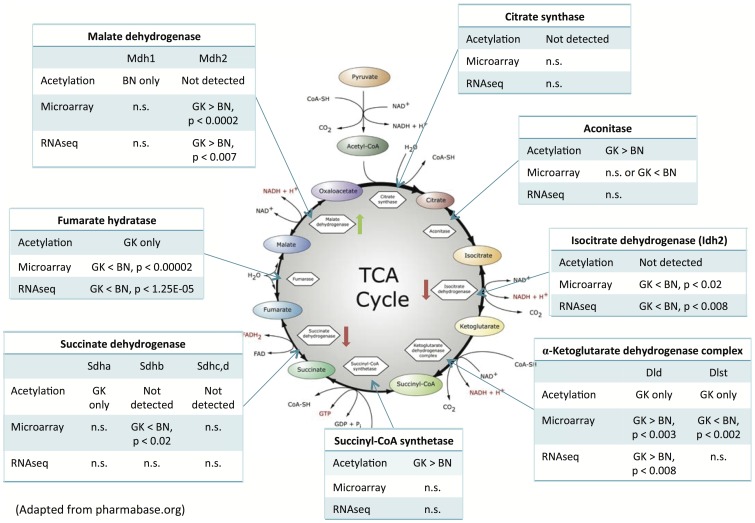
Lysine acetylation and mRNA expression in components of TCA cycle.Green arrow pointing up (next to malate dehydrogenase) indicates acetylation causes increase in enzyme activity. Red arrow pointing down (next to isocitrate dehydrogenase and succinate dehydrogenase) refers to decrease in enzyme activity with acetylation.